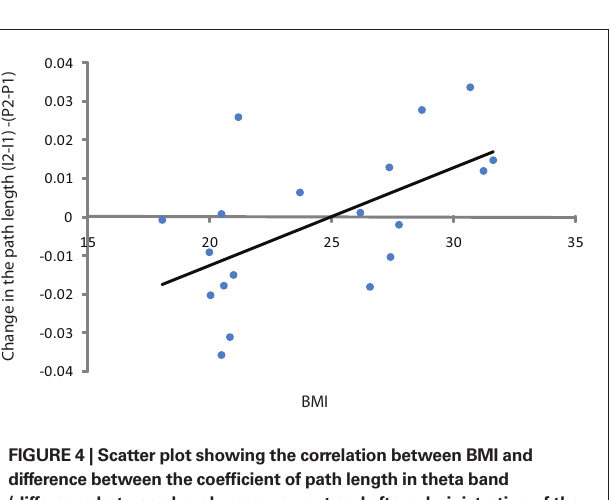
FiGurE 3 | Bar plot showing the (A) insulin induced change in the cluster coefficient in the lean and obese group (B) insulin induced change in the path length in the lean and obese group. All data are given as mean ± SEM, * p < 0.05.